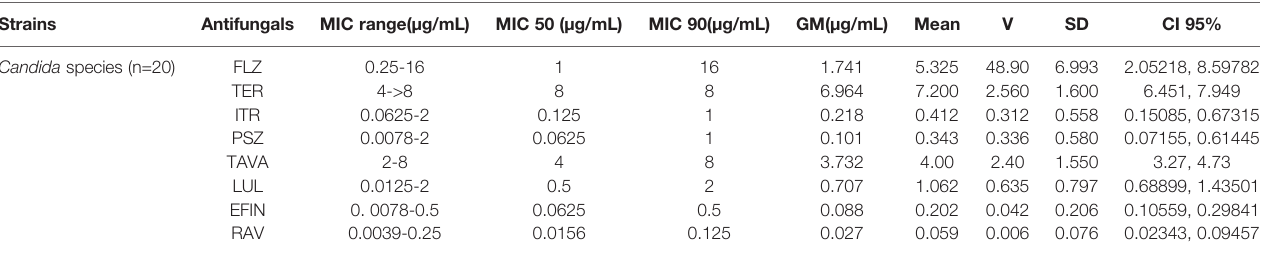
TABLE 4 | The geometric mean, MIC ranges, MIC50 and MIC90 values obtained by testing the susceptibility of yeast isolates to each antifungal agent.